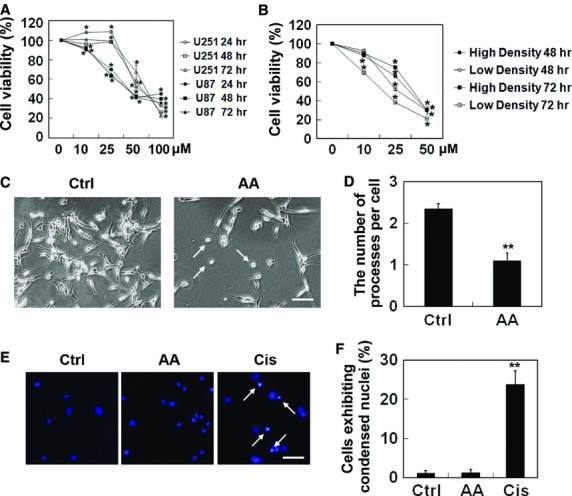
Cytotoxic activity of aurantiamide acetate on in vitro cultured human malignant glioma U87 and U251. (A) U251 and U87 cells were seeded into 96-well plates at a density of 1000 cells/well. Twenty-four hours after initial seeding, cells were treated with different concentrations of aurantiamide acetate (0, 10, 25, 50 or 100 μM). Following different time period (0, 24, 48 or 72 hrs) of drug incubation, the cell viability was determined by MTT. (B) U87 cells were seeded into 96-well plates at a density of 500 cells/well (low density) or 1500 cells/well (high density). Twenty-four hours after initial seeding, cells were incubated with aurantiamide acetate (0, 10, 25 or 50 μM). Following different time period (0, 48 or 72 hrs) of drug incubation, the cell viability was determined by MTT. (C) Representative cellular morphology after 48-hrs incubation of 25 μM aurantiamide acetate (AA). Dead cells were indicated by arrows. (D) The number of processes per cell was quantified from six micrographs. At least 30 cells per micrograph were analysed. (E) Cells treated with 25 μM AA or 2.5 μg/ml cisplatin (Cis) for 48 hrs were stained with Hoechst 33342. Apoptotic cells were indicated by arrows; scale bars, 50 μm. (F) The proportion of cells exhibiting condensed apoptotic nuclei was calculated from 20 micrographs. *P < 0.05; **P < 0.01 compared with control.